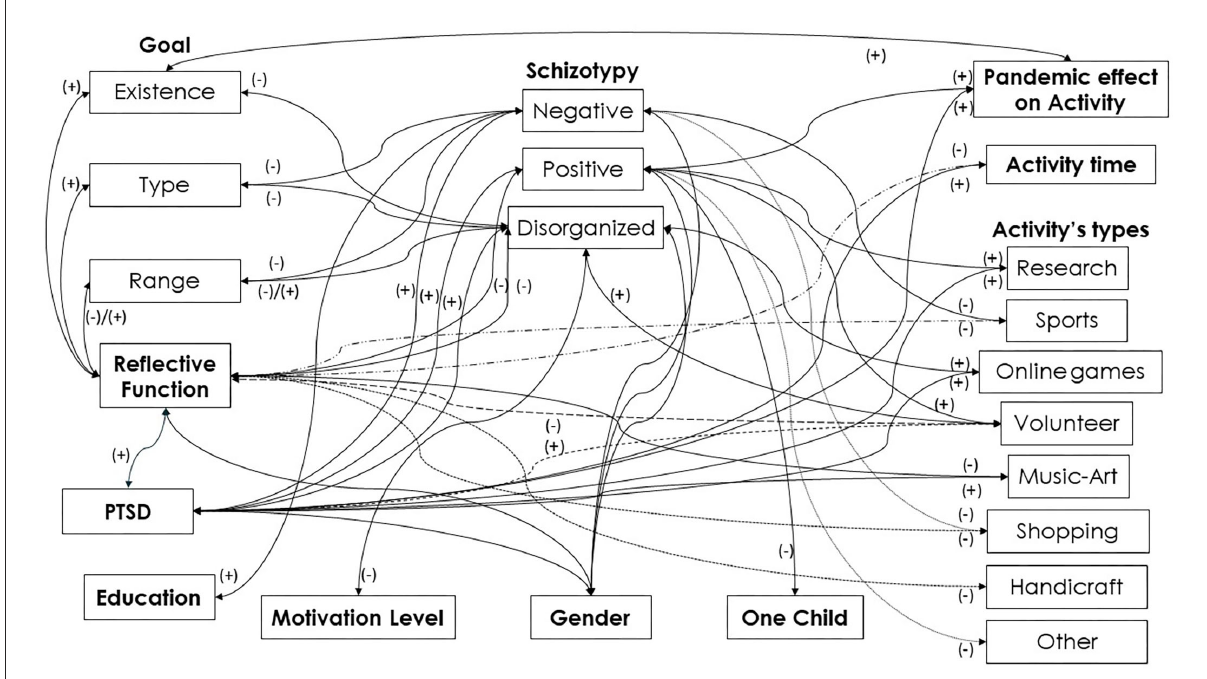
FIGURE1 Variables’